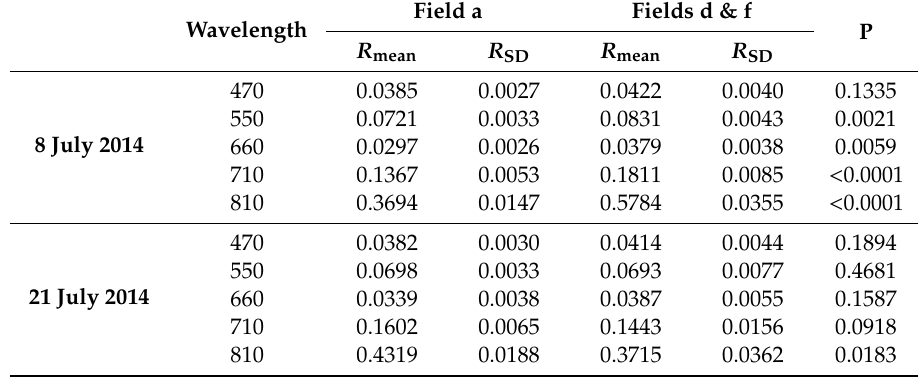
Table 3. Comparison of Mini-MCA reflectances of potato fields on two dates. Field labels are shown in Figure 1. R mean and R SD are reflectance (dimensionless) mean and standard deviation, respectively; P is the probability* that the null hypothesis was